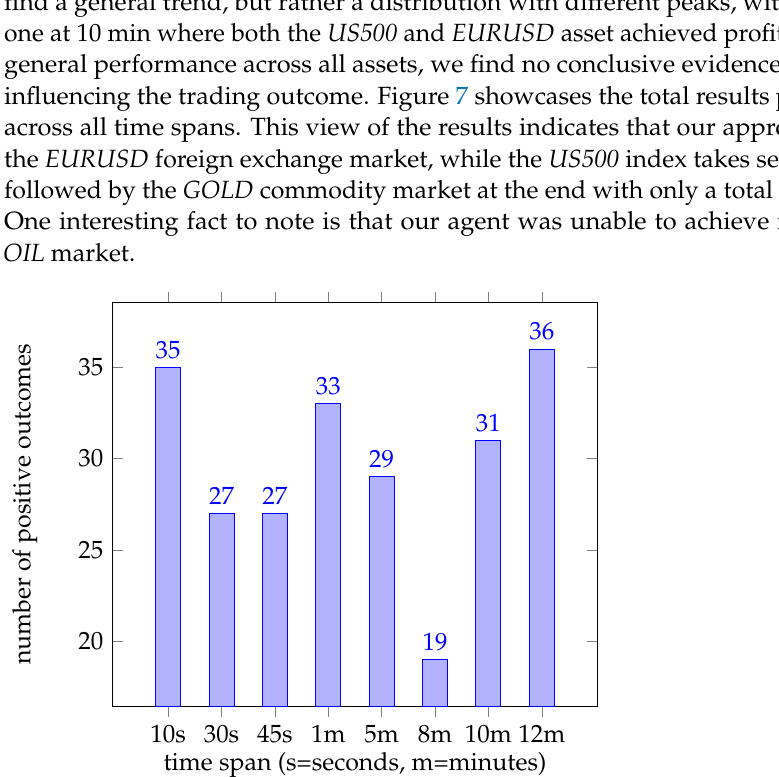
Figure 6. The number of positive outcomes over all tests with a certain observation period. As shown in the chart, one can find the highest distribution of wins at the 12 min mark, closely followed by 10 s, while by far, the lowest distribution is found at the 8 min point.